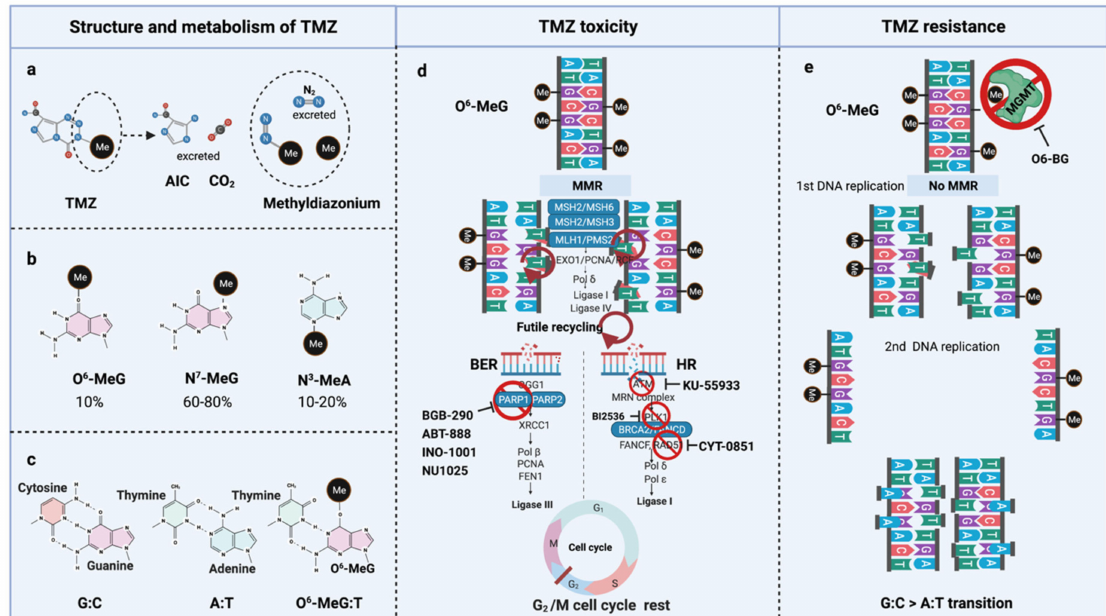
Figure 3. TMZ molecular structure, metabolism, toxicity, and resistance. ( a ) TMZ structure and metabolism, ( b ) DNA methylation upon TMZ, ( c ) DNA base mispair upon DNA methylation, ( d ) mechanism of TMZ toxicity with intact MMR, BER, and HR, ( e ) mechanism of TMZ resistance with functional MGMT and non-functional MMR. AIC, 4- Amino-5-imidazolecarboxamide; BER, Base-excision repair; HR, Homologous repair; MGMT, O 6 -methylguanine-DNA- methyltransferase; MMR, Mismatch repair; MLH, MutL homologue; MSH, MutS homologue; PMS, Post-meiotic segregation; TMZ,